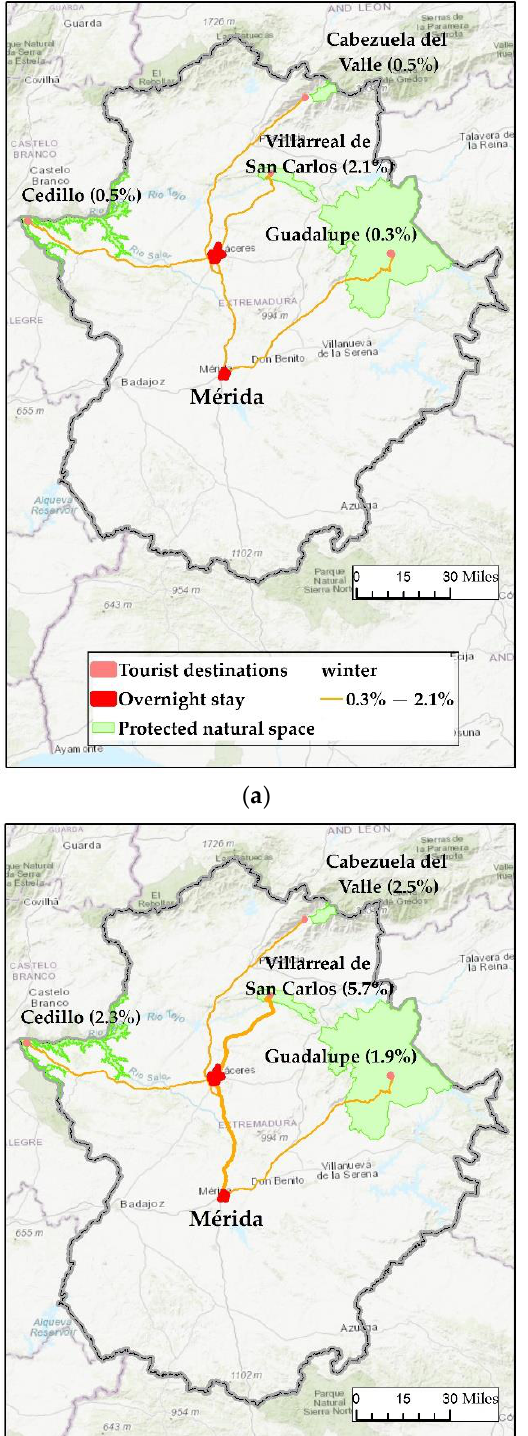
13 of 22 Figure 4. Journeys made by tourists spending the night in Cáceres: ( a ) winter; ( b ) spring; ( c ) summer; ( d ) autumn. The inference that can made from analyzing journeys made by travelers from Mérida (Figure 5) is that Monfragüe National Park is the most popular place for tourists whatever the season, although spring has the largest influx of visitors (8.4%), followed by summer and autumn, with much lower values of 5.7% and 4.7%, respectively; in contrast, winter accounts for barely 2% of visitors. These are logical figures if we consider that the travel time from Mérida to Villarreal de San Carlos is almost 2 hours. The second most visited place is the Geopark, which was chosen by 11.3% of those who spent the night in Mérida, from where the travel time is 106 minutes. Despite its strong capacity of attraction, it is much more popular in spring than in other seasons, accounting for 7.7% of visits. This might be related to the proximity of Guadalupe, which is a center of attraction for religious tourism, especially taking into account that spring and Easter coincide. The rest of the year, many fewer visitors are attracted to the area, and winter continues to be the least popular season.